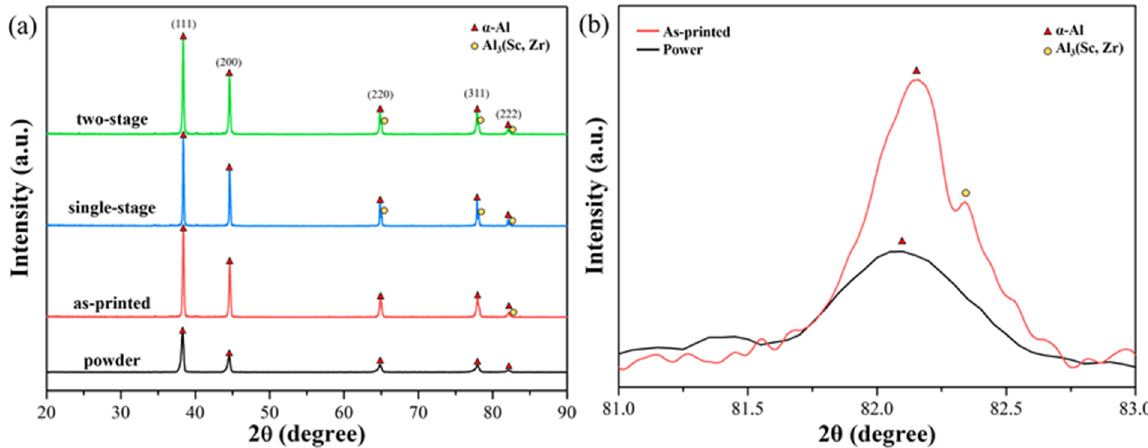
Figure 4. ( a ) X-ray diffraction pattern of the SLM Al–Mg–Sc–Zr alloys, obtained over a wide range of 2 θ values. ( b ) X-ray diffraction pattern in the vicinity of the peak of α -Al (2 θ = 82°).